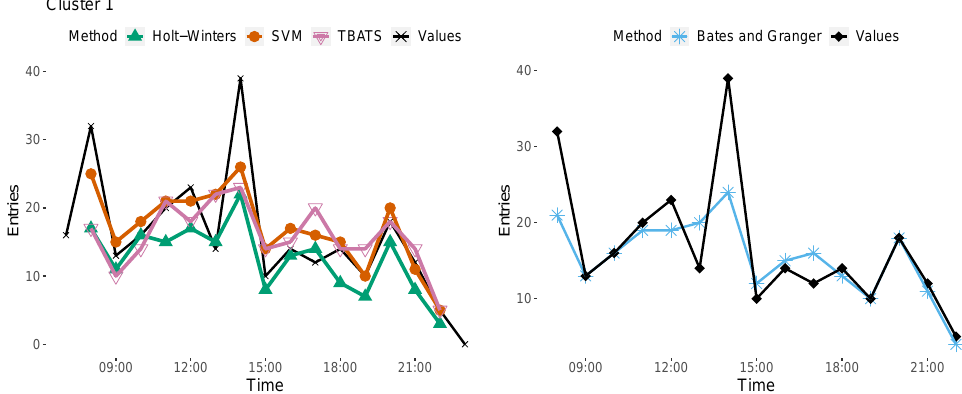
Figure 9. Cluster 1 best 3 models ( left ) and final combined predictions ( right ). Cluster